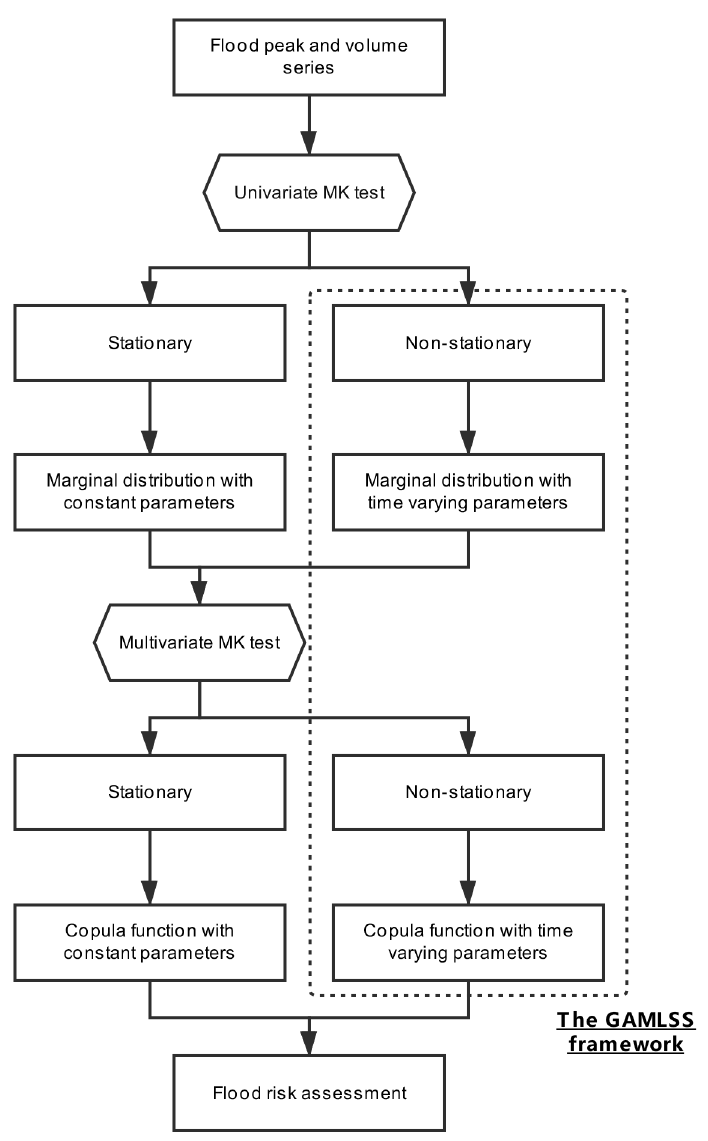
Figure 2. The procedure for constructing the time varying copula model.